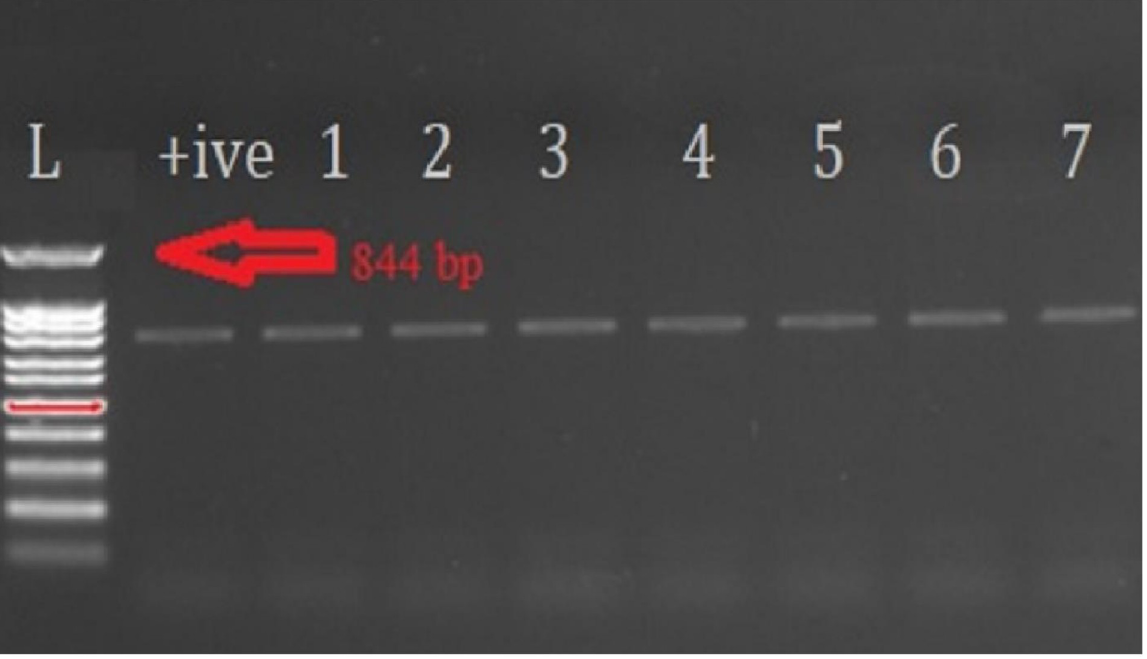
PLOS ONE | https://doi.org/10.1371/journal.pone.0269194 June 3,